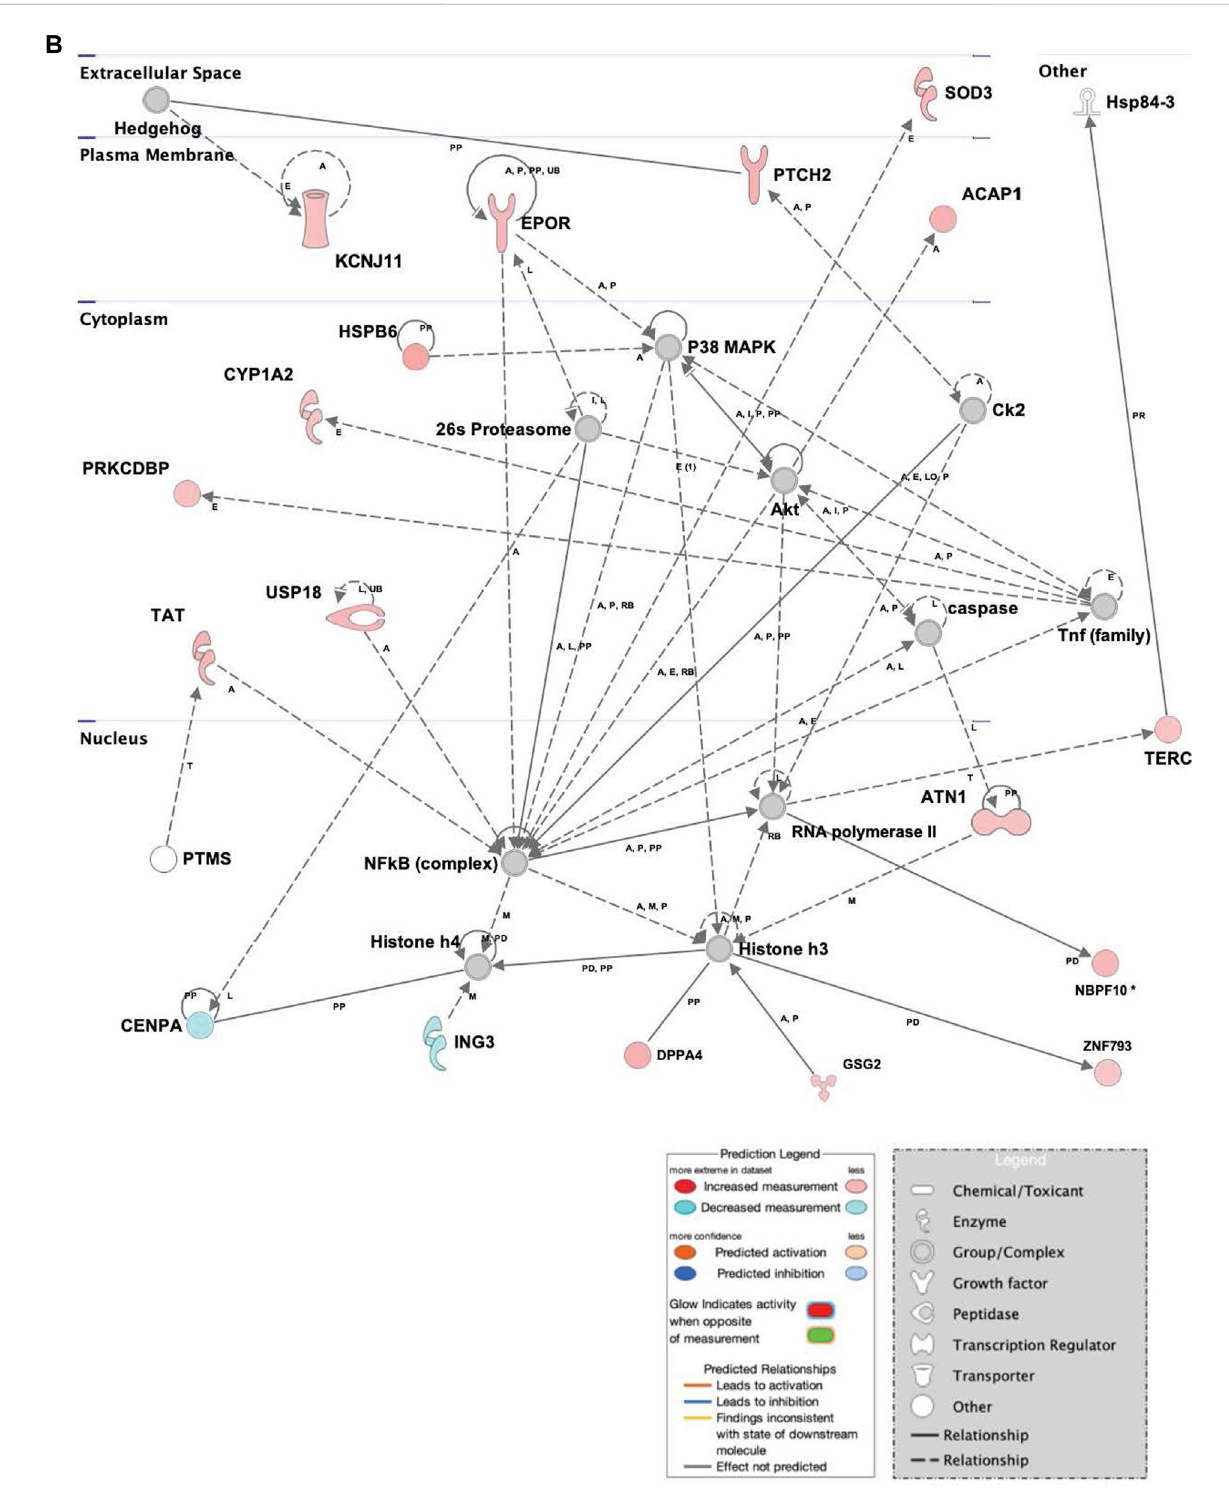
FIGURE 4 Network displays interactions between genes regulating cell signaling, cellular function and maintenance, and vitamin and mineral metabolism that were differentially expressed in hASCs treated for 60 min with S.T compared with untreated control. Upregulated genes are colored in shades of red, downregulated in shades of green ( p -value ≤ 0.05). IPA inserted Genes in white because they are connected to this network; dashed and solid lines denote indirect and direct relationships between molecules. The IPA molecule activity predictor assessed the activity of molecules strongly connected to this network; blue and orange colored molecules are predicted to have decreased and increased activity, respectively. Shapes associated with each gene name and broad category indicate the general classi fi cation of the gene product, enzyme, growth factor,